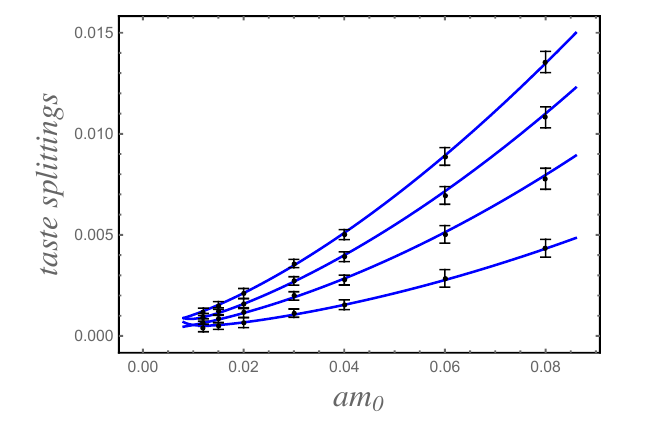
Figure 4. Fit of tree-level SdChPT to the taste splittings of Ref. [3]. Taken from Ref.